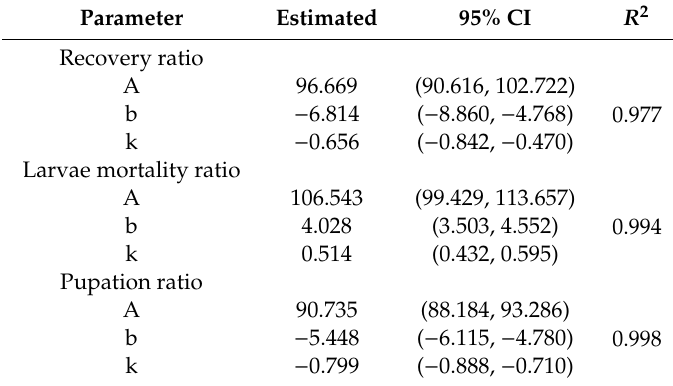
Table 2. Estimated parameters, confidence intervals, and R 2 for a logistic model of recovery ratio, larvae mortality ratio, and pupation ratio fitted to experimental data of immersed B. minax